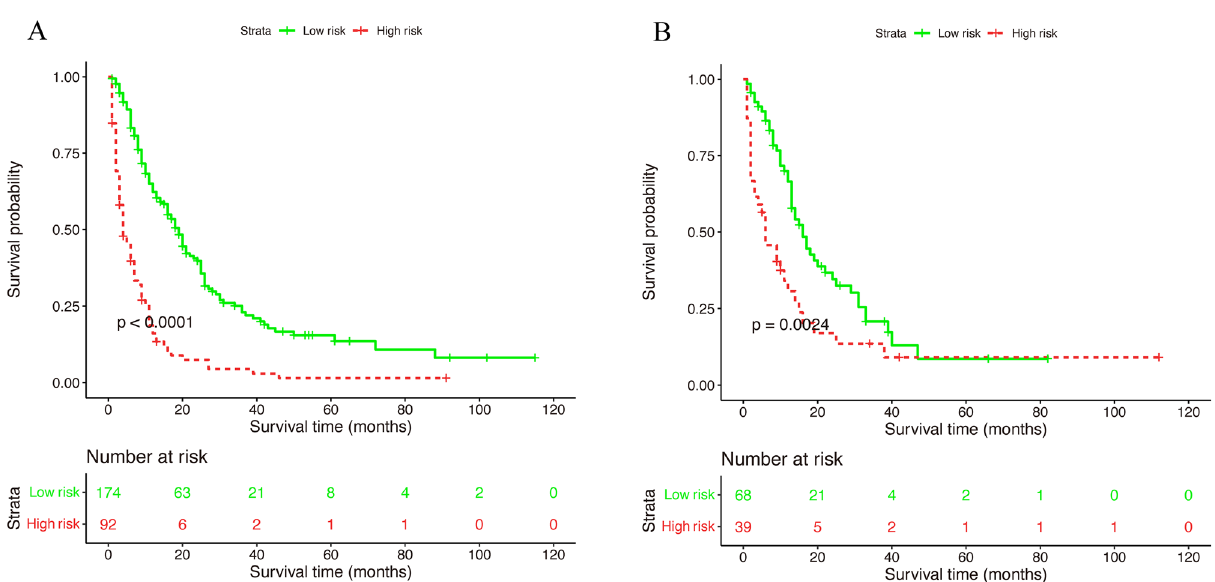
Figure 6. Kaplan–Meier survival curves of nomogram for CSS in the training cohort ( A ) and validation cohort ( B ). CSS, cancer-specific